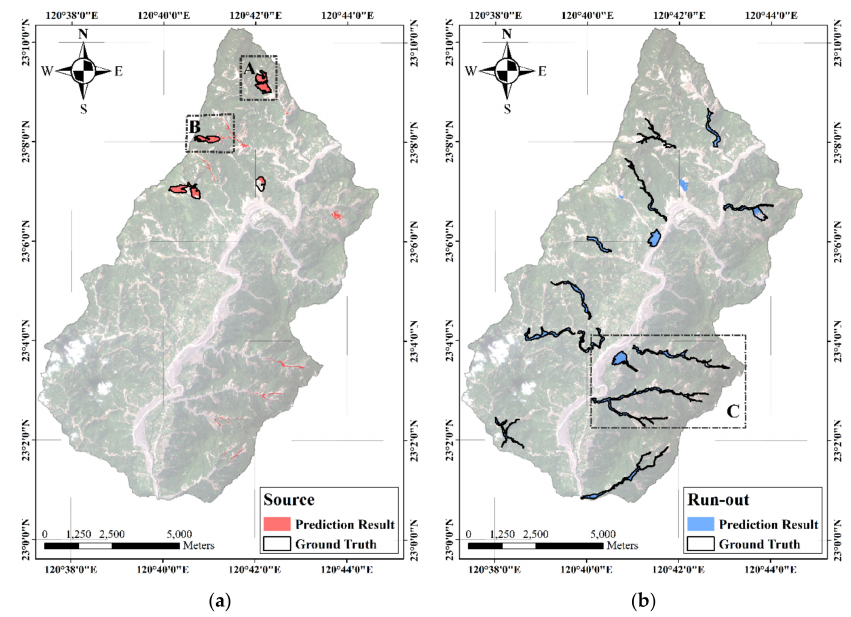
Figure 14. Prediction results of the No. 3 model using the RF algorithm to separate landslide source and runout signatures with the areas of inventory polygons of ≥ 100,000 m 2 . Cases of ( a ) landslide source and ( b ) runout polygons.